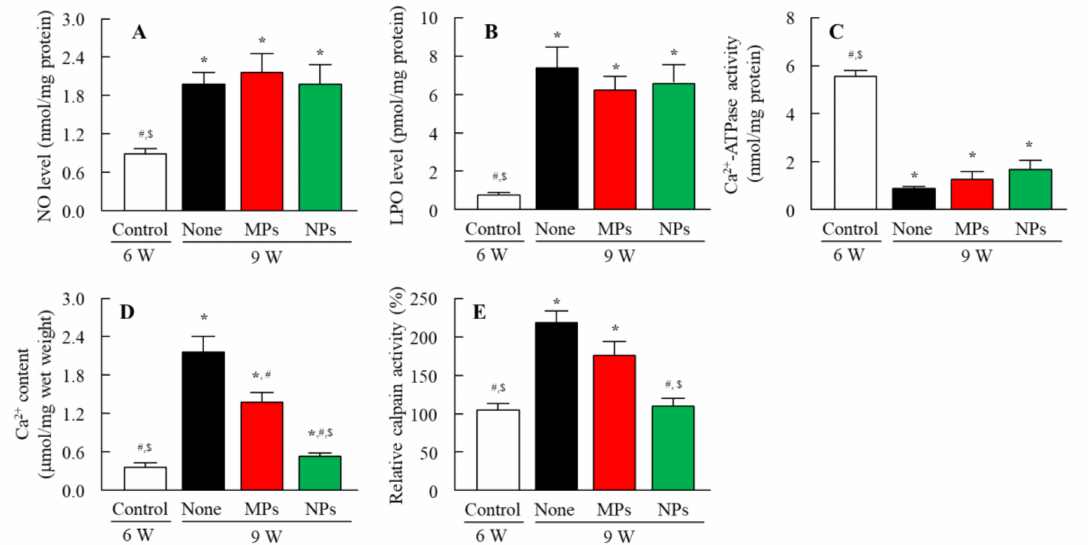
Figure 8. Changes in NO levels ( A ), LPO levels ( B ), Ca 2+ -ATPase activity ( C ), Ca 2+ content ( D ), and calpain activity ( E ) in the lenses of 9-week-old SCRs repetitively instilled with NIL-NPs. The 6-week-old SCRs were repetitively instilled with NIL dispersions for 3 weeks (once a day). Control: non-instilled SCRs aged 6 weeks (transparent lens). None: non-instilled SCRs aged 9 weeks. MPs: NIL-MP-instilled SCRs aged 9 weeks. NPs: NIL-NP-instilled SCRs aged 9 weeks. n = 4–9. * p < 0.05, vs. control for each group. # p < 0.05, vs. none for each group. $ p < 0.05, vs. MPs for each group. The repetitive instillation of NIL-NP dispersions significantly prevented enhanced Ca 2+ content and calpain